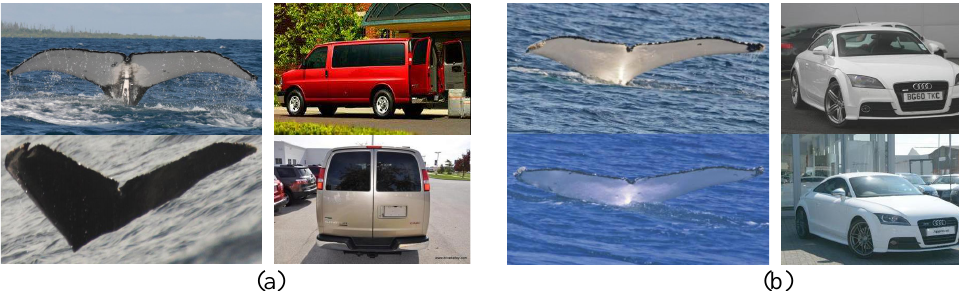
Figure 1. Data examples: although the poses of the two whales in ( a ) are different, they belong to the same category. The other two whales in ( b ) are not identical, although they look similar. The same phenomenon exists with respect to the vehicles in the Cars-196